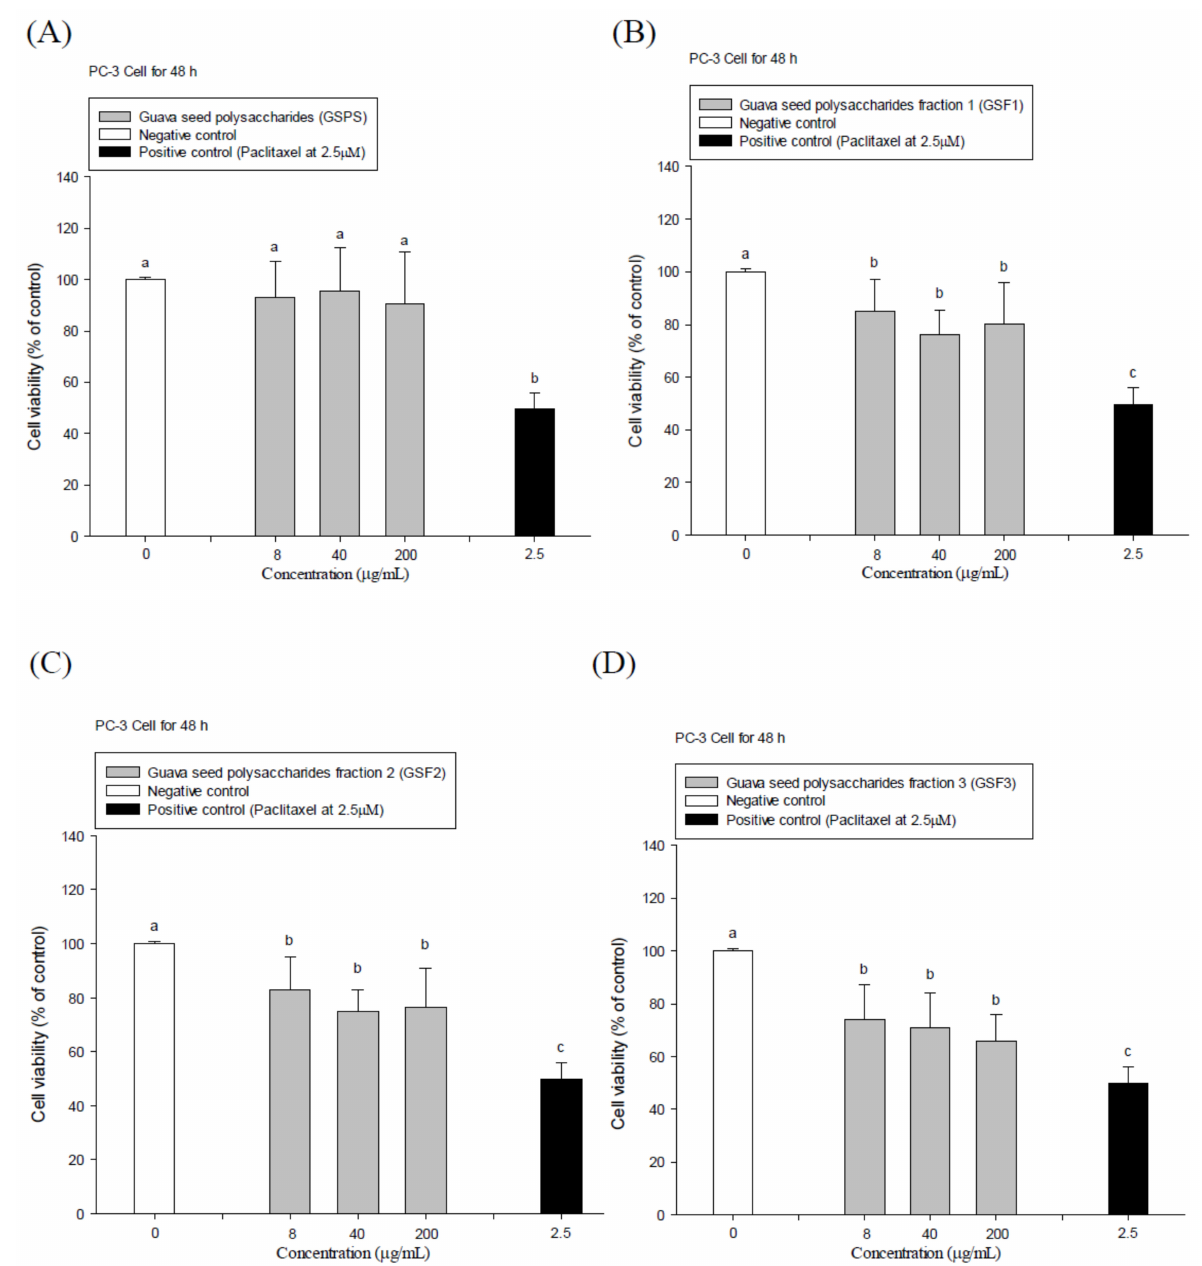
Figure 2. Effects of direct treatments with guava seed polysaccharides (GSPS) ( A ), GSF1 ( B ), GSF2 ( C ), and GSF3 ( D ) for 48 h on PC-3 cell growth. Values are means ± SD (n = 6 biological determinations). Bars in the plot not sharing a common letter are significantly different ( p < 0.05) from each other analyzed by one-way ANOVA, followed by Duncan’s multiple range test. Each cell population (2 × 10 5 cells/mL) was respectively treated with the polysaccharide at the indicated concentrations of 8, 40, and 200 µ g/mL, as well as paclitaxel (a positive control) at 2.5 µ M. The cell viability was determined using MTT